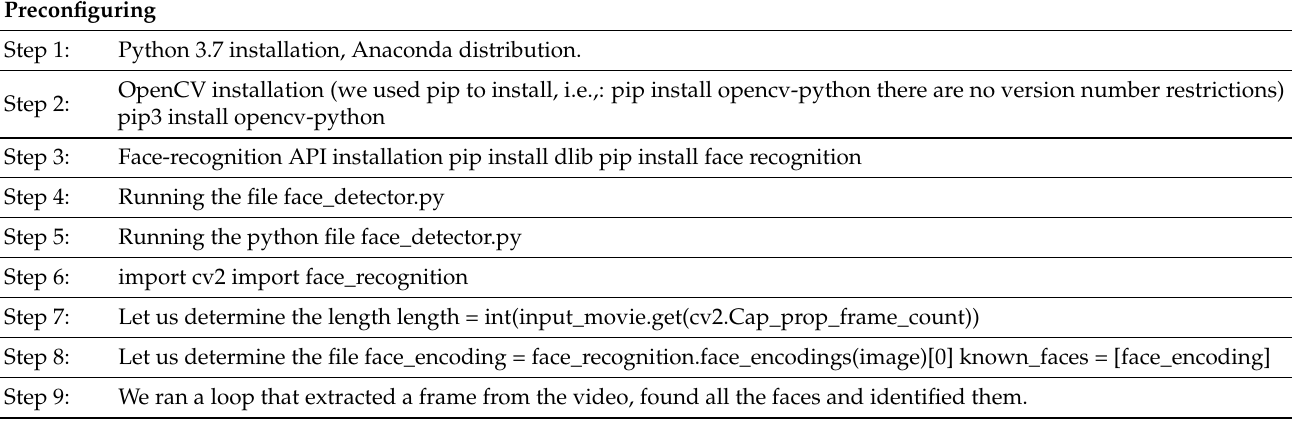
Table 2. Preconfiguring the